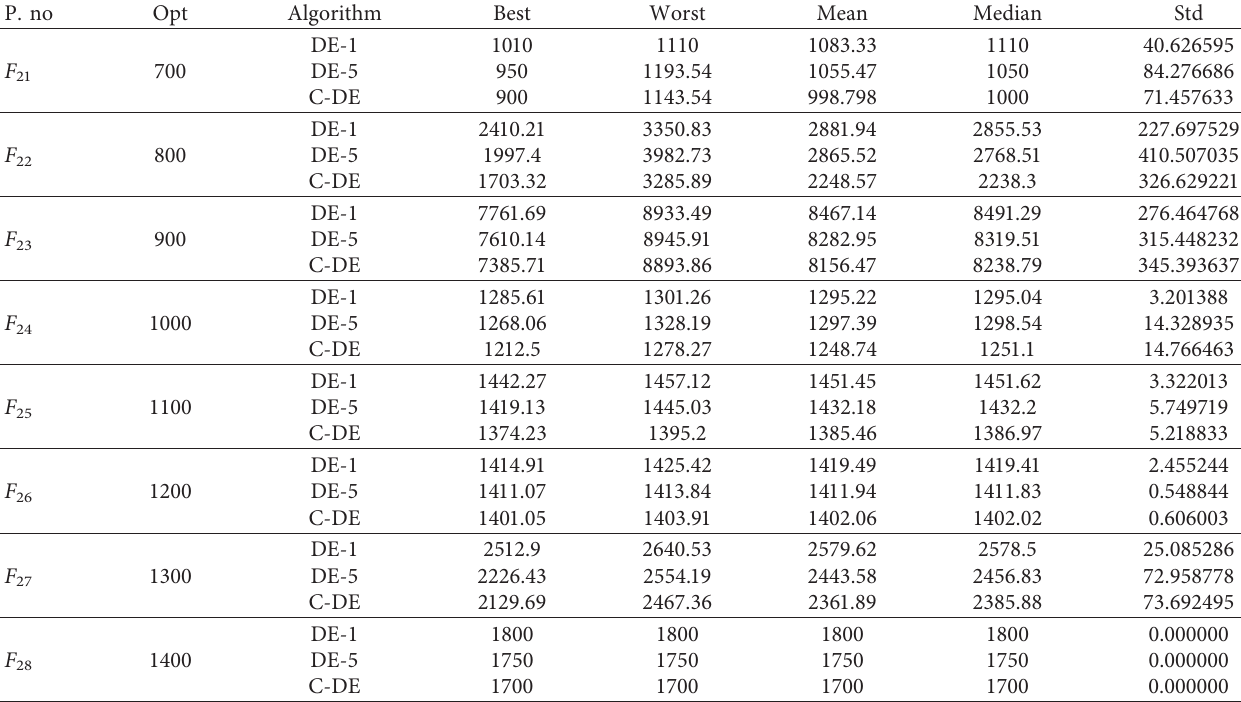
Table 5: The experimental results obtained by DE-1 and DE-5 versus proposed C-DE by solving CEC’13 benchmark functions F n � 30 dimensions. P.